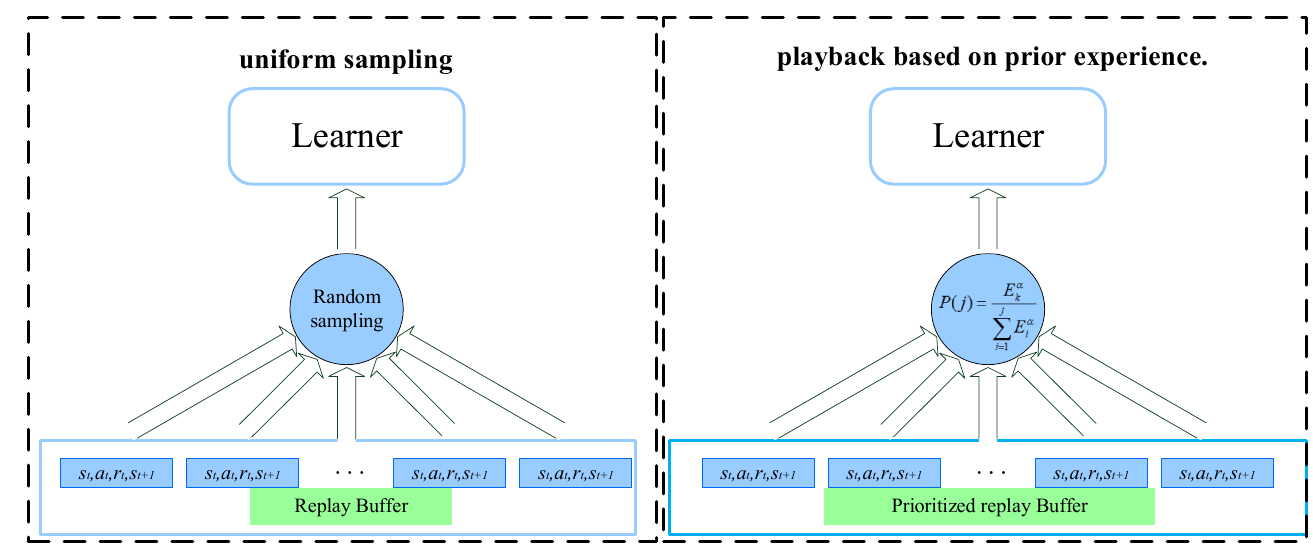
Figure 8 . Comparison of the two sampling methods. Figure 8. Comparison of the two sampling methods. The sampling weights is shown in Equation (33), where β is a hyper parameter used to smoothen the high variance weights to offset the degree to which prior experience replay affects the results. The optimization of the loss function of its critic estimation network is shown in Equation (34). The flowchart of the algorithm is shown in Algorithm 1.